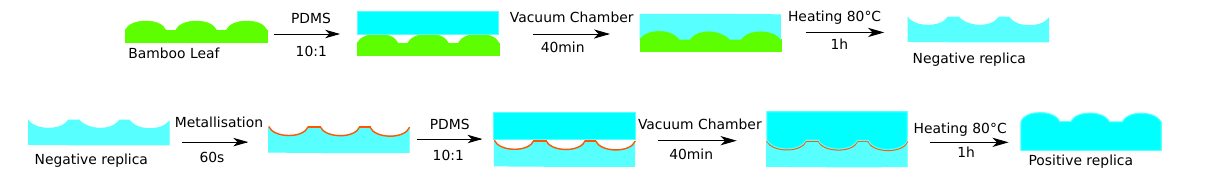
Figure 2. Schematic representation of the fluor-free PDMS-replication